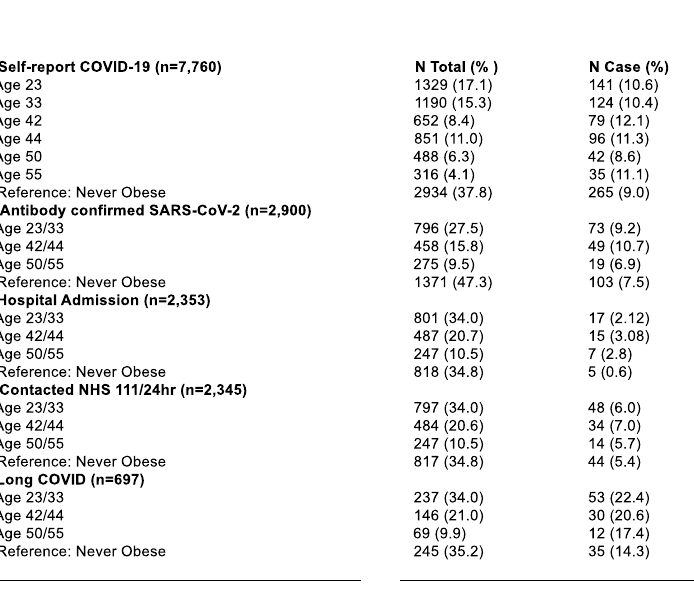
with health services, the reference category is “no admission” and “no contact”, respectively. For long COVID the reference category is “acute COVID-19”. N total represents the total number of people in each age category, whilst N case represents the number of cases within each age category. Log scale used to report Odd Ratios on X